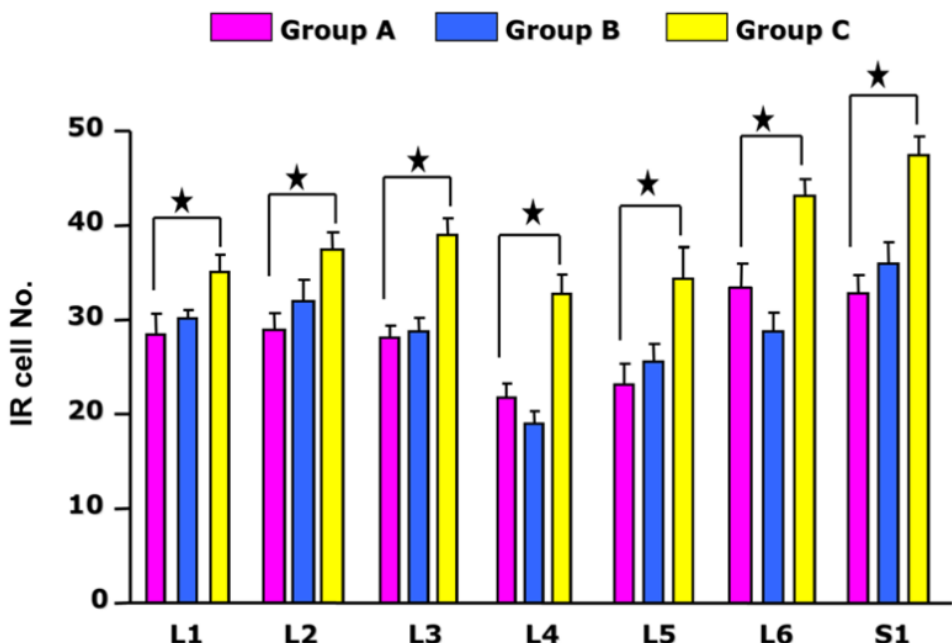
Figure 3. Histogram demonstrating the number of p-CREB immunoreactive cells in each group: control (group A), acute E.coli infection (group B) and chronic E.coli infection (group C). In the chronic cystitis group, p-CREB immunoreactivity (p-CREB-IR) in the L1–L6 and S1 DRG was significantly higher than control group ( p < 0.05). Further, p-CREB-IR in the L3–L6 and S1 DRG of the chronic cystitis group was significantly greater than that in the acute cystitis group ( p < 0.05). In the control and acute cystitis groups, p-CREB-IR in the L4–L5 DRG was significantly lower than that found in the other DRG sections ( p < 0.05). ★ means statistical significance.